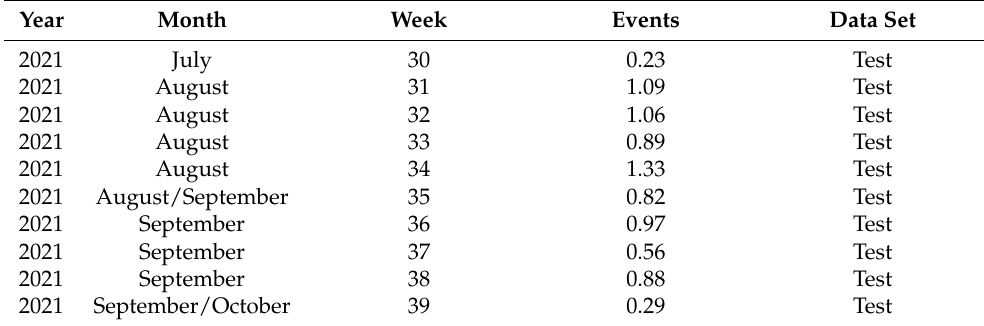
Table A2. Additional test split for 2021 data set. Events are shown in millions ( × 10 6 ) in the